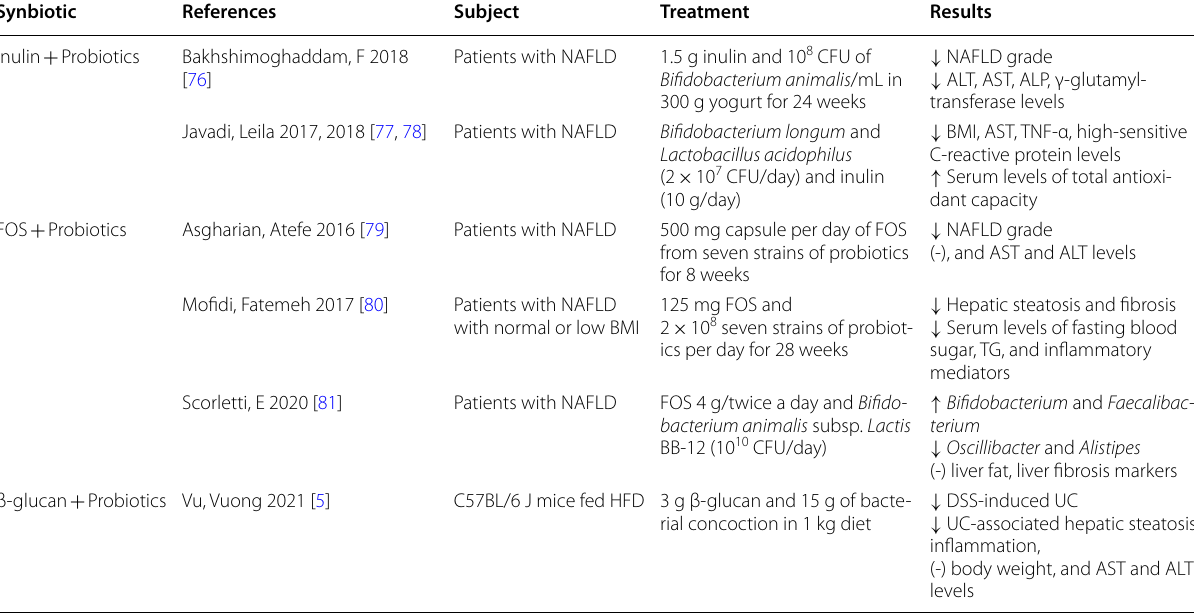
ALP alkaline phosphatase, ALT alanine aminotransferase, AST aspartate transaminase, BMI body mass index, CFU colony-forming unit, DSS dextran sulfate sodium, FOS fructooligosaccharide, HFD high-fat diet, NAFLD non-alcoholic fatty liver disease, TNF-α tumor necrosis factor alpha, UC Ulcerative colitis A positive or upward effect is denoted by ( ), a negative or downward effect is denoted by ( ), and an insignificant effect is denoted by ( )